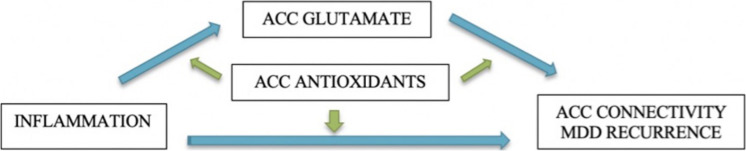
Conceptual model and study aims. Green arrows indicate moderation of associations.